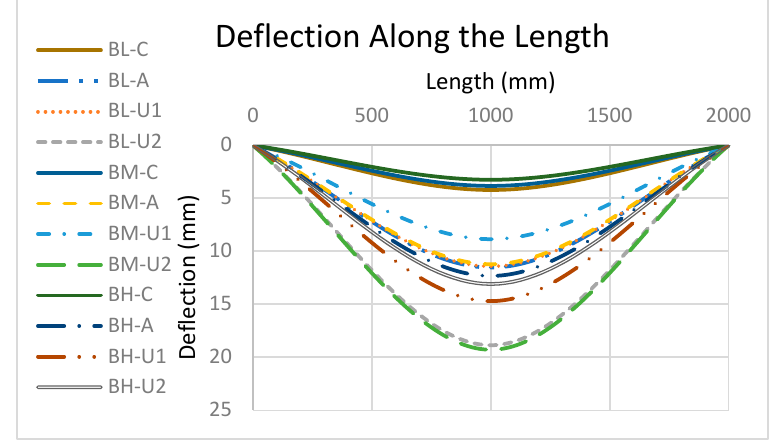
Figure 13. Deflection along the beams’ length.